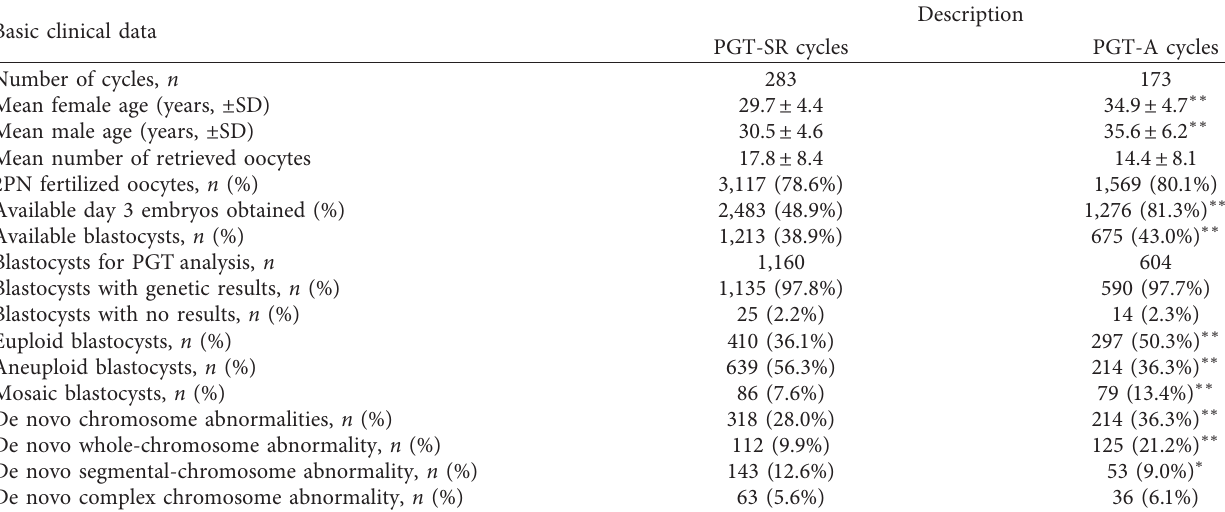
Table 1: Basic data of PGT cycles in the study.